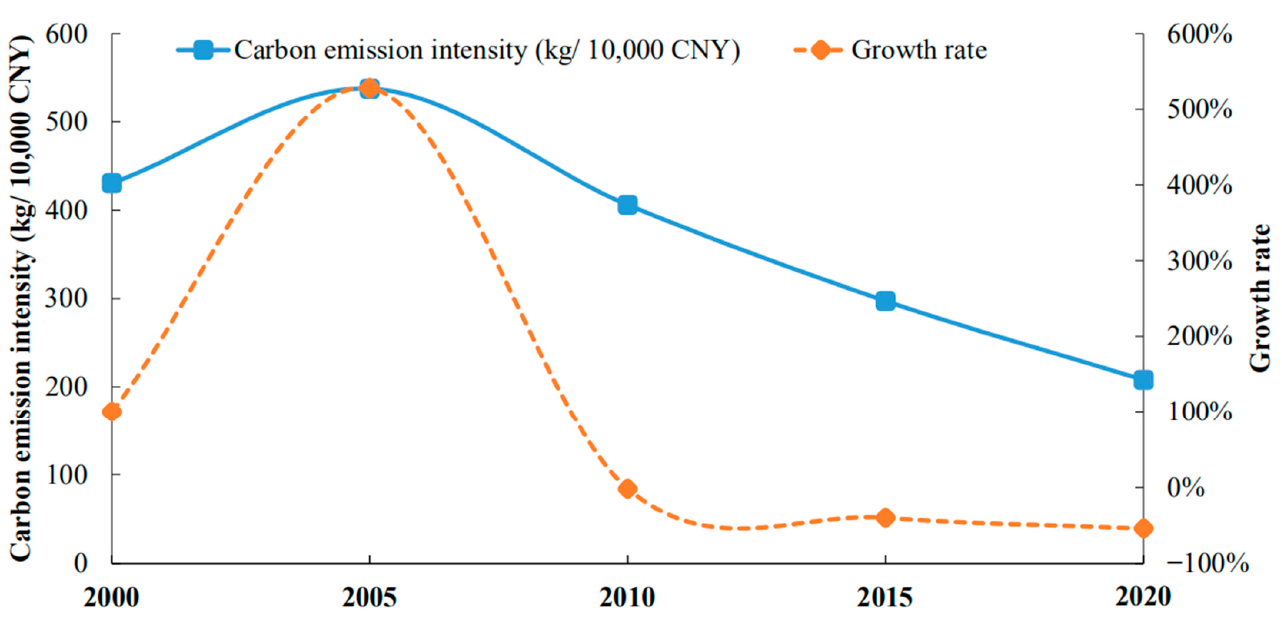
Figure 6. Time series change of carbon emission intensity and growth rate.